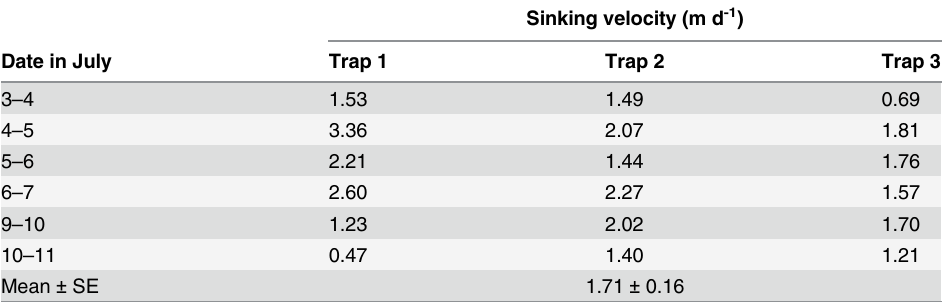
Table 4. In situ sinking velocity of Bosmina longirostris carcasses calculated from Eq 6 using data from Table 1 for Lake Stechlin.